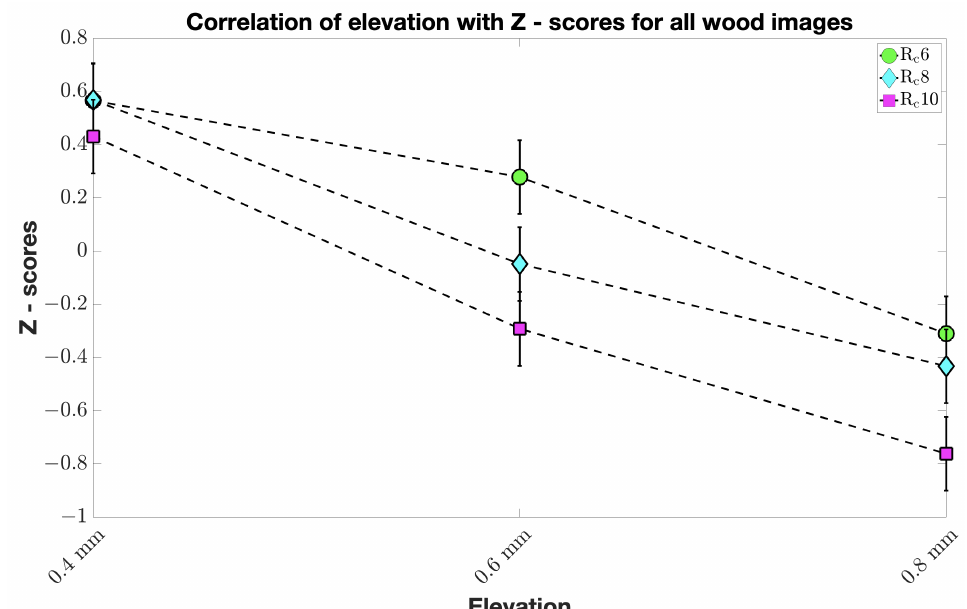
Figure 9. Correlation of elevation with Z-scores for all wood images. The x-axis represents 2.5D prints at various elevation levels. We can observe that the observers found lower elevation natural for all wood images, regardless of the roughness levels, as the CI s